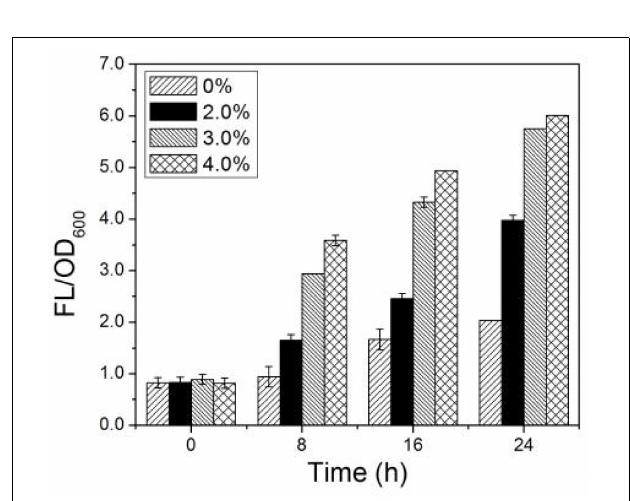
FIGURE 6 | Time-courses for FL/OD 600 for simulated bioleaching system with varied pulp